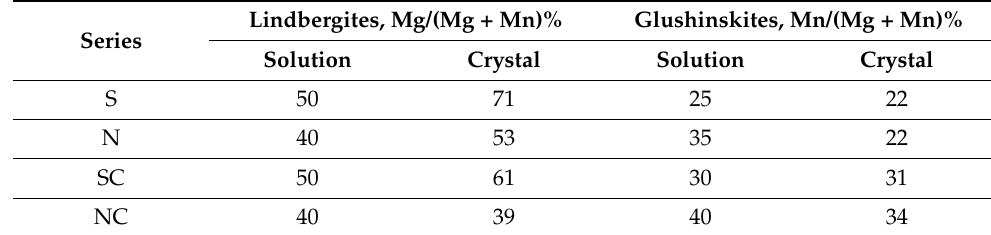
Table 3. Limiting concentrations of Mg/Mn in lindbergites/glushinskites within single-phase pre- cipitates.